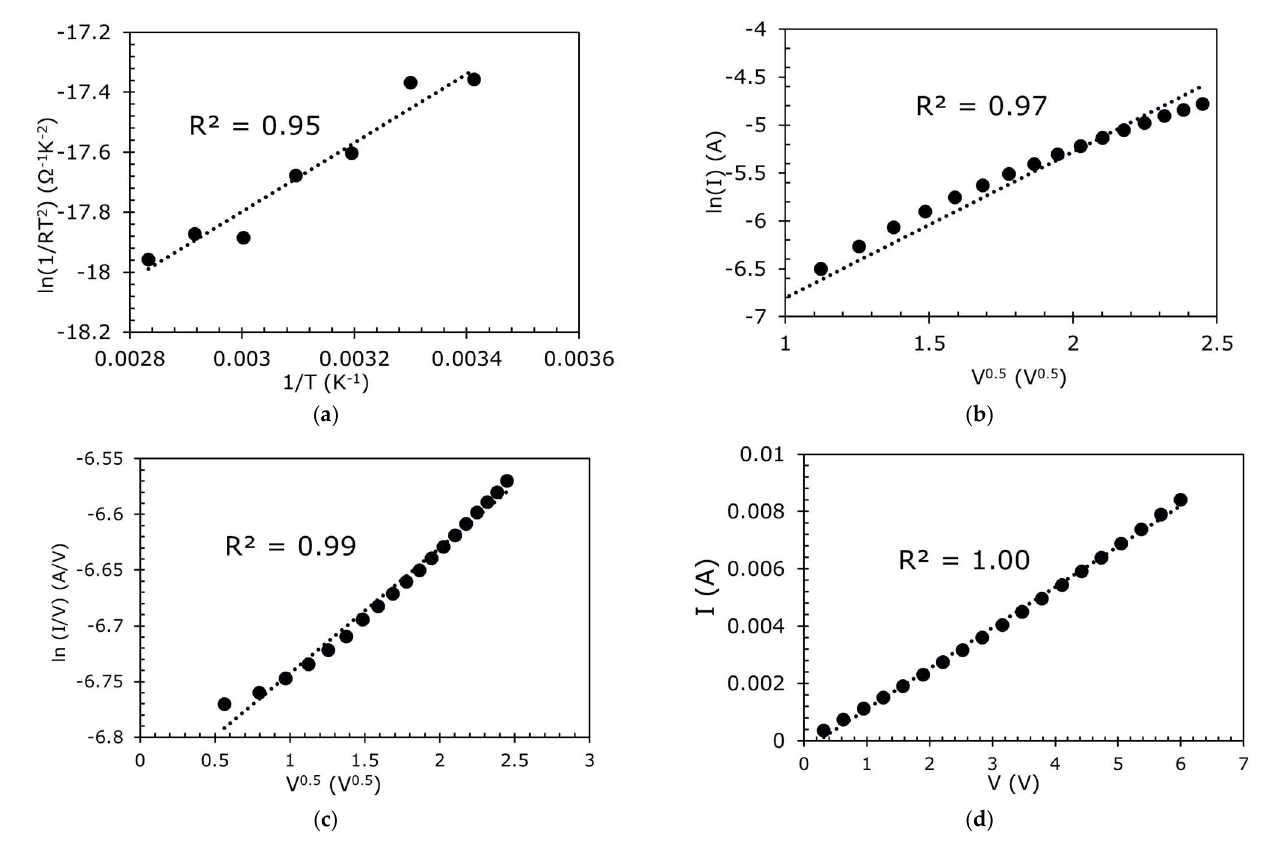
Figure 6. ( a ) Temperature variation in the sensor and its fit to Schottky or thermionic emission, I – V plots of the sensor and fitted with ( b ) Schottky or thermionic emission, ( c ) Poole–Frenkel, and ( d ) Ohmic conduction in Region I. ( d ) Ohmic conduction in Region I.